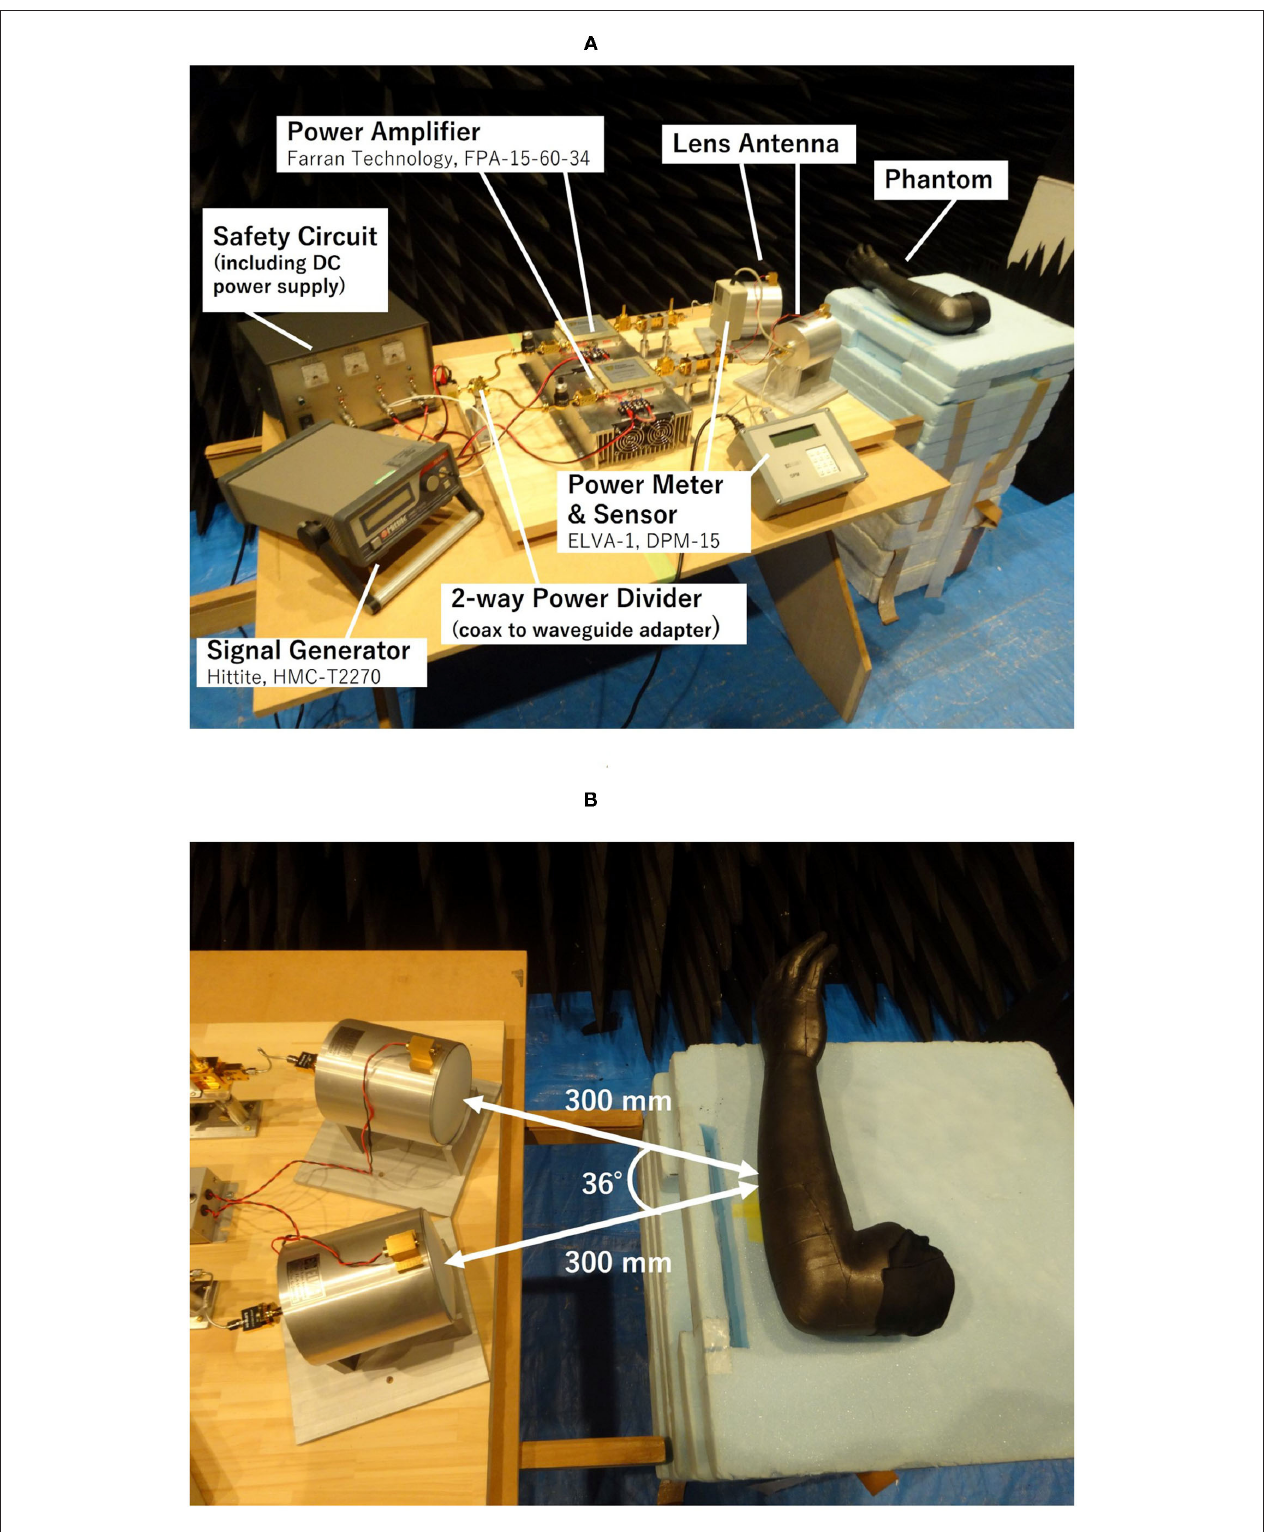
FIGURE 6 | 60 GHz spatial synthetic exposure setup. (A) Overview of the setup. (B) The lens antenna and arm-shaped phantom.